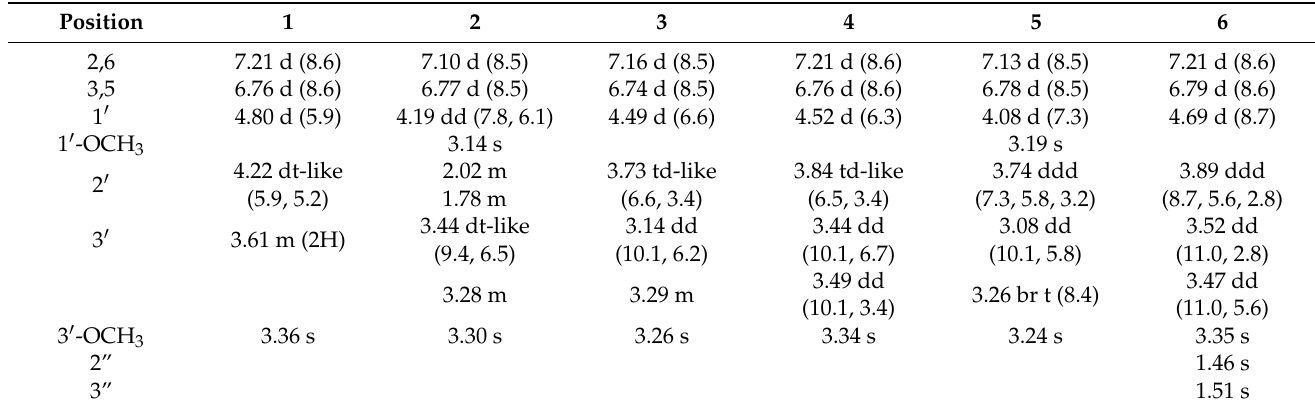
Table 1. 1 H-NMR spectroscopic data for compounds 1 – 6.